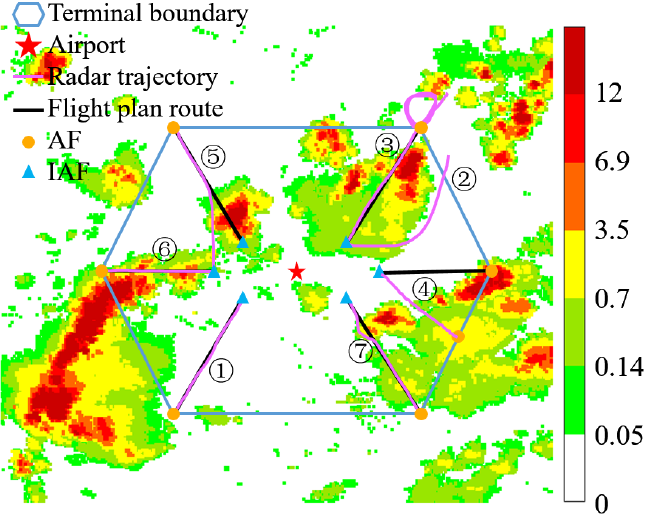
Figure 4. Explanation of arrival flight operation strategies.